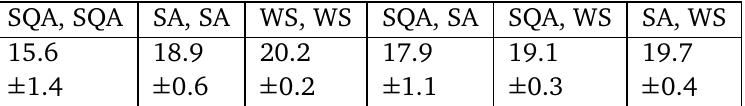
Table 1: This table shows the average Hamming distance between two solutions, found by different solvers, of a randomly generated 4-SAT. The value provided is the average taken over ≈ 8.06. The solutions were randomly 20 randomly generated instances with n = 50 and α χ 4 chosen among the solutions found within 800 runs by the respective solvers. Truly independent solutions would have an average Hamming distance of 25.